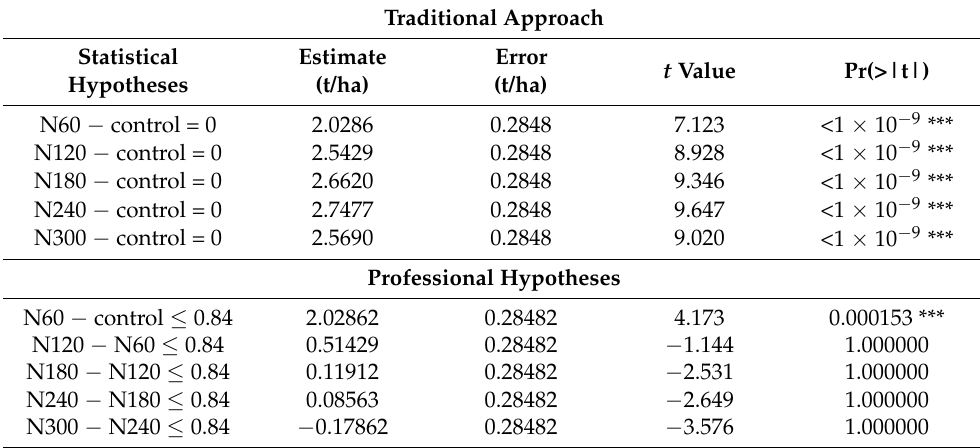
Table 2. Results of the simultaneous tests for general linear